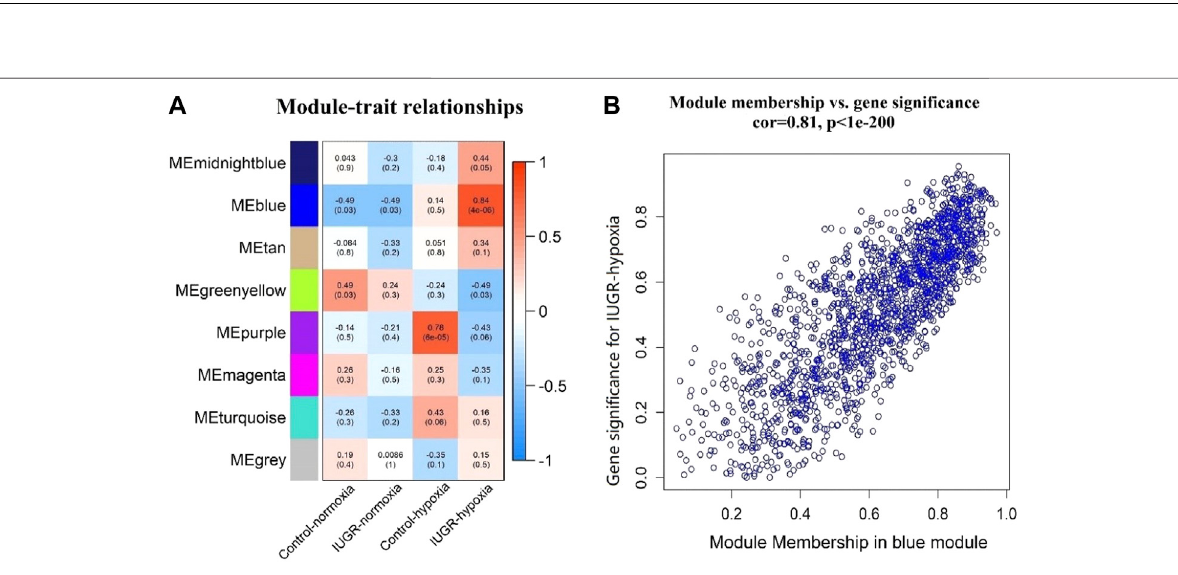
FIGURE 4 | Identi fi cation and veri fi cation of clinical related modules. (A) Module – trait associations. Each row corresponds to a module eigengene, while each column corresponds to a trait. Each cell contained the correlation coef fi cients and p -value. (B) Scatterplot of gene signi fi cance (GS) vs. module membership (MM) in the blue module. The correlation coef fi cients and p -value are listed above the